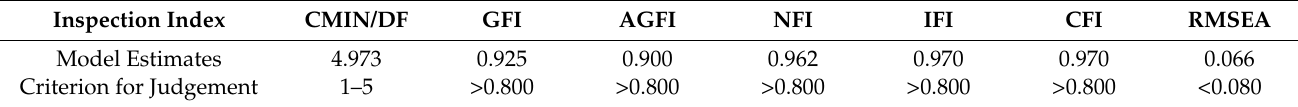
Table 6. Structural equation model fitting